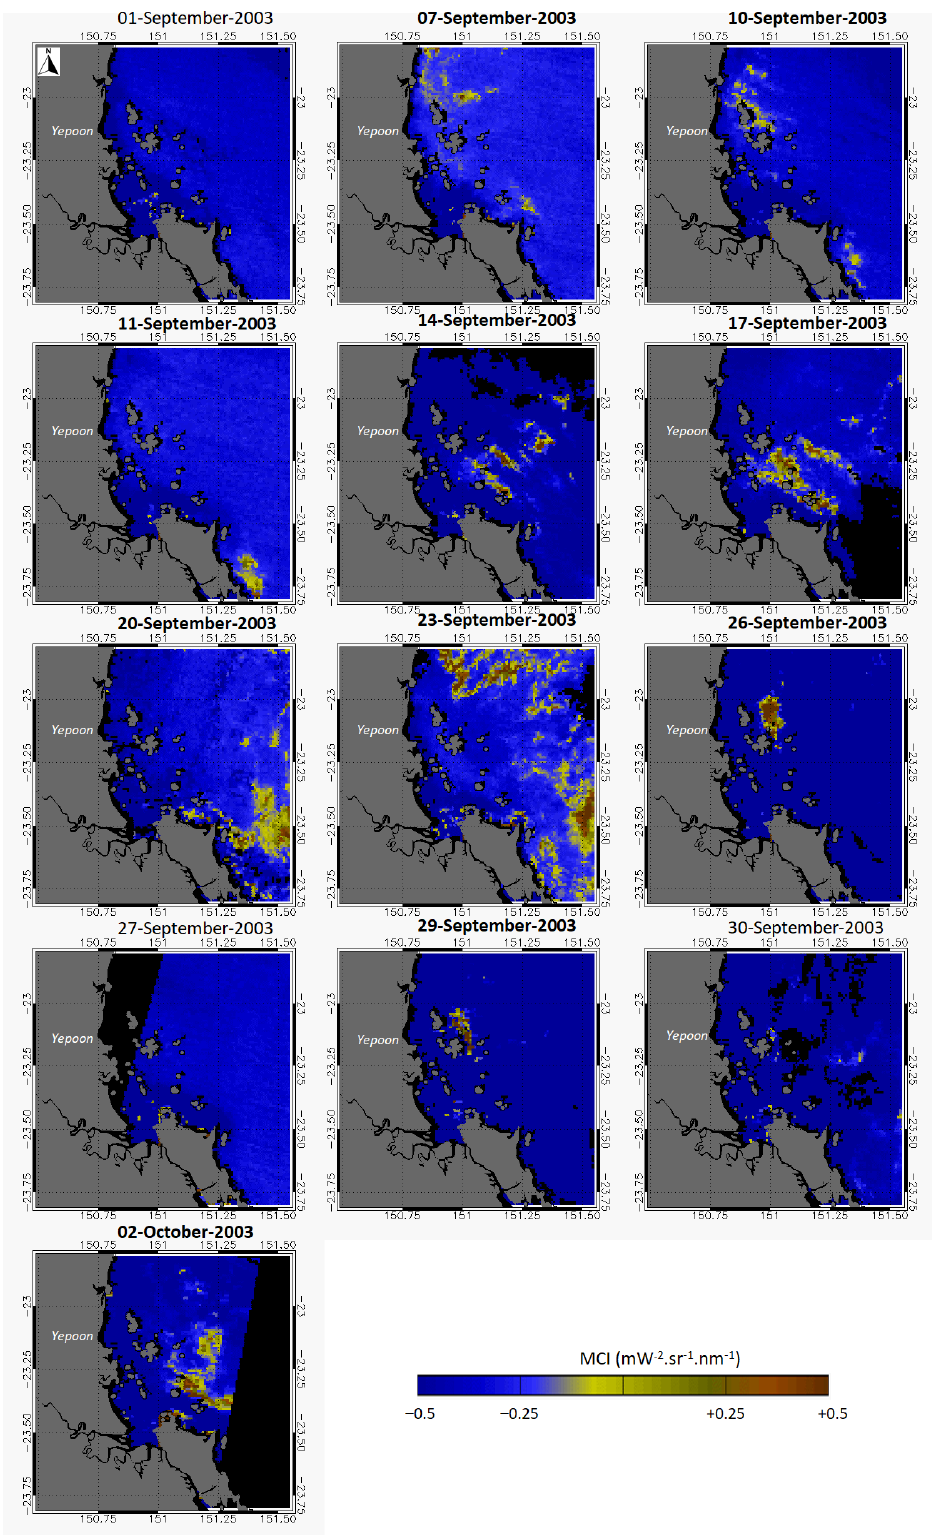
Figure 2. Time-series of Envisat MERIS reduced resolution scenes processed with the MCI over the region of interest between 1 September and 2 October 2003 showing the development of a surface bloom event. Dates in bold characters indicate the presence of surface bloom expressions detected by the MCI. The colour scale varies from dark blue to red, with warmer colours denoting an increase in algal bloom surface expressions. Masked pixels and missing data are shown in